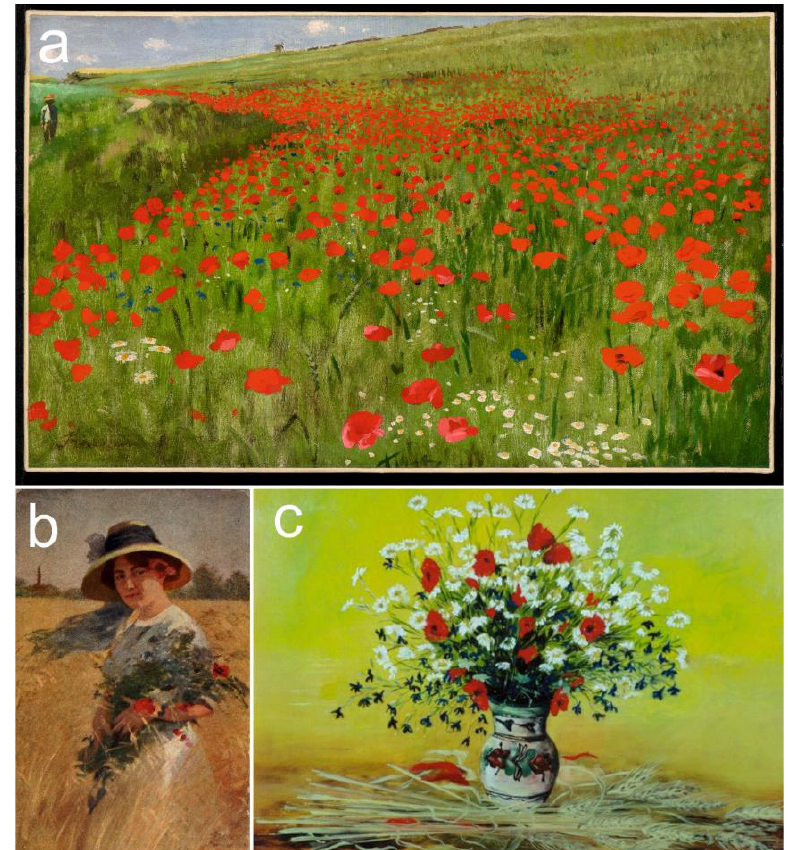
Figure 12. Hungarian paintings featuring arable wildflowers; ( a ) Meadow with poppies (Pál Szinyei Merse, 1896; Museum of Fine Arts, Budapest; © Szépművészeti Múzeum 2022); ( b ) Summer (The reproduction cards of the ‘Publisher Könyves Kálmán’. Reproduced after: A hatted lady with a bouquet of arable wildflowers, Fülöp Szenes, 1913. Courtesy of Bedő Papírmúzeum); ( c ) Bouquet of arable wildflowers (Gizella Czeglédi, 1999. Courtesy of Gizella Czeglédi).